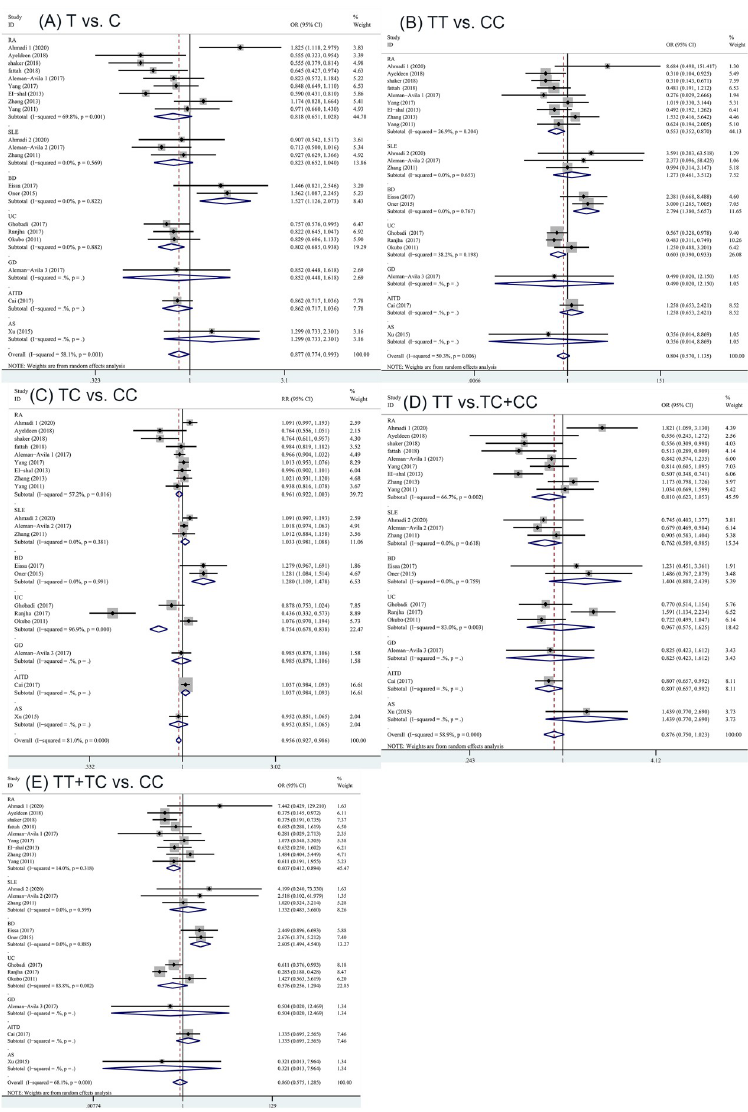
Fig 6. Stratified analysis of the association of the miRNA-499 rs3746444 polymorphisms with the autoimmune diseases by type of autoimmune diseases. (A) T vs. C, (B) TT vs. CC, (C) TC vs. CC, (D) TT vs. TC+CC, (E) TT+TC vs. CC; (RA, rheumatoid arthritis; BD, Behcet’s disease; UC, ulcerative colitis; SLE, systemic lupus erythematosus; GD, Graves’ disease; AITD, autoimmune thyroid diseases; AS, ankylosing spondylitis).